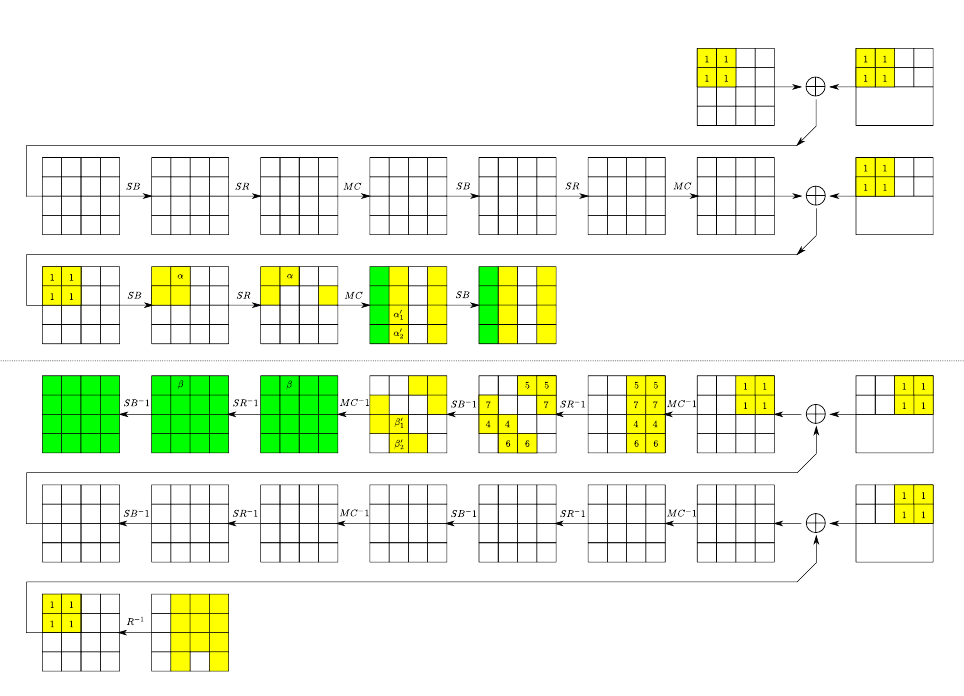
Figure 7: The 7-round boomerang distinguisher of